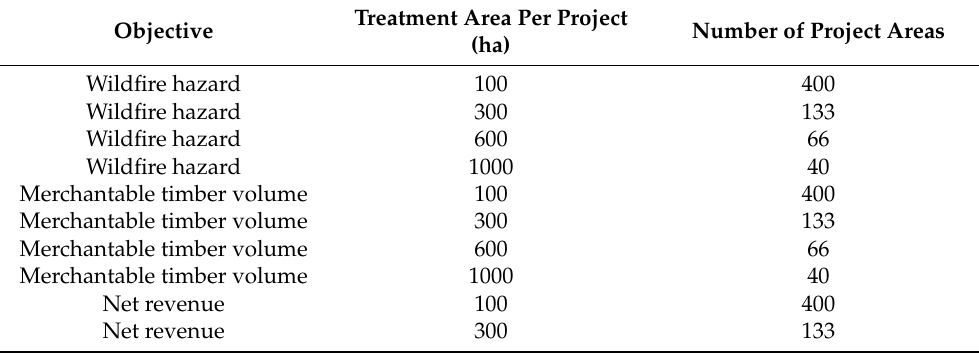
Table 2. Description of scenarios simulated to prioritize project areas. See the methods section for additional description of the scenario